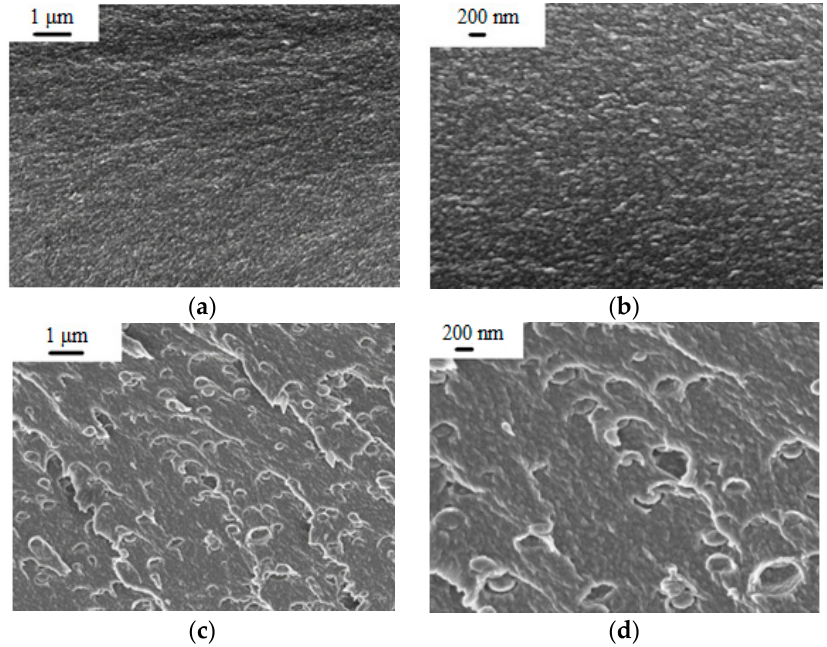
Figure 4. SEM images of membrane cross-section: ( a,b ) PEA and ( c,d ) PEA–Cu(I).